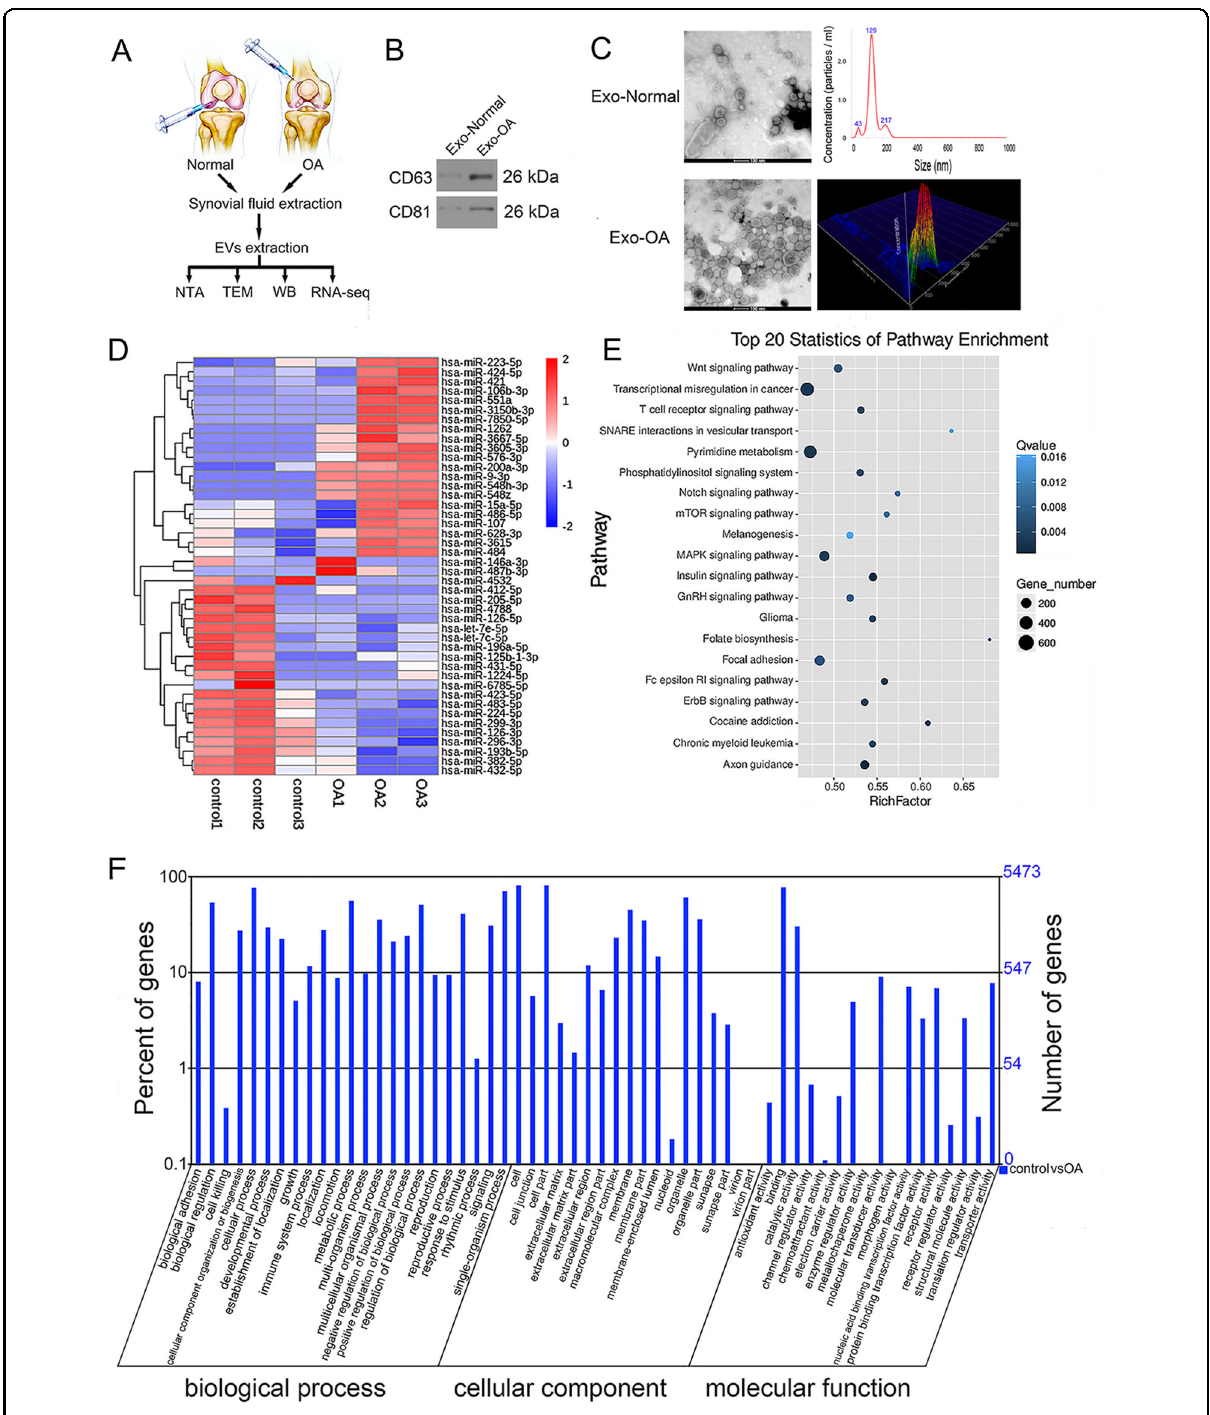
Fig. 1 Exosomes derived from human synovial fl uid and bioinformatics analysis for exosome-encapsulated miRNAs. A The synovial fl uid of NON-OA and OA patients was obtained. Then the extracellular vesicles obtained by ultra fi ltration assay were collected and analyzed. B The indicated protein levels (CD63 and CD81) in exosome-like vesicles were detected by western blotting. C The morphology of exosome-like vesicles was observed under TEM and NanoSight detection was measured. D Heatmap label for aberrantly expressed miRNAs in synovial fl uid exosomes of patients with OA. E , F The KEGG pathway annotation and GO analysis were